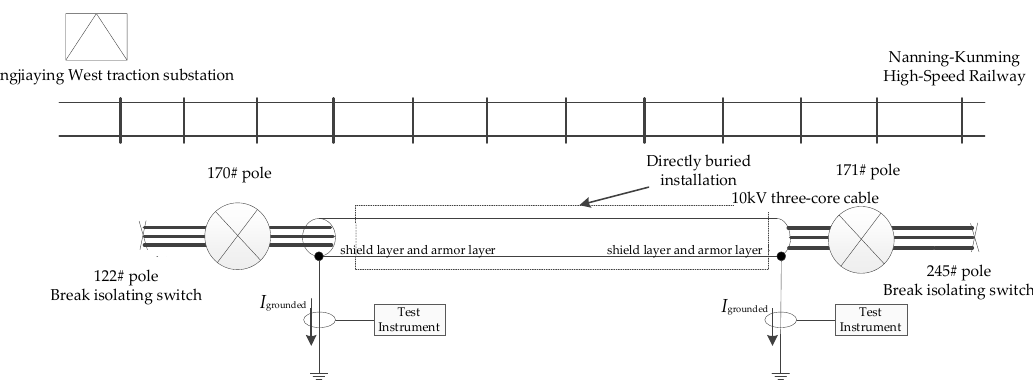
Figure 9. “Nankun 1” 10 kV feeder cable double-end grounding test structure.